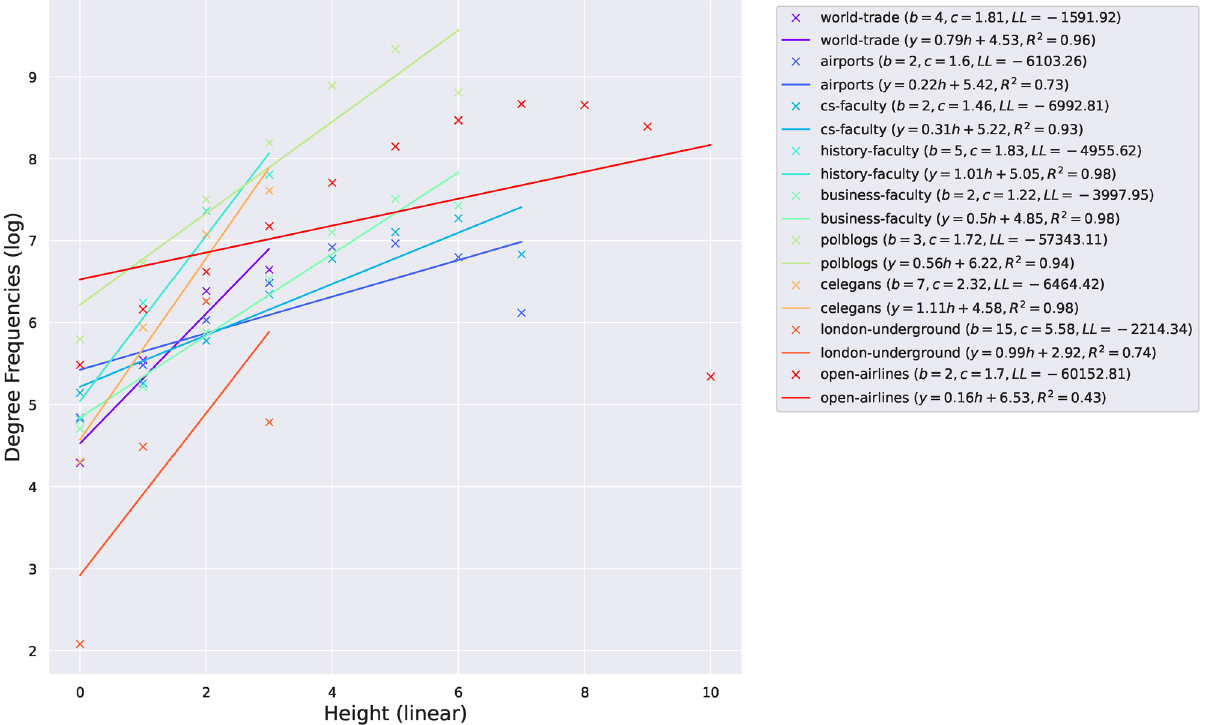
Figure 1. Results of fitting an IGAM model to the world-trade, cs-faculty, history-faculty, business-faculty, and airports datasets examined in Ref. 9,24–27 . The Figure displays the predicted values of b and c for the IGAM model, and the total degree at each level h of the skeleton tree of fanout b . A linear fit is presented for each dataset to showcase the power law behaviour. Moreover values of the log-likelihood (LL), and Pearson’s Correlation Coefficient R 2 are reported. Nodes with degree ≤ 4 have been filtered out as outliers except for the London- underground network. Source code to reproduce the Figure can be found in Ref. 33